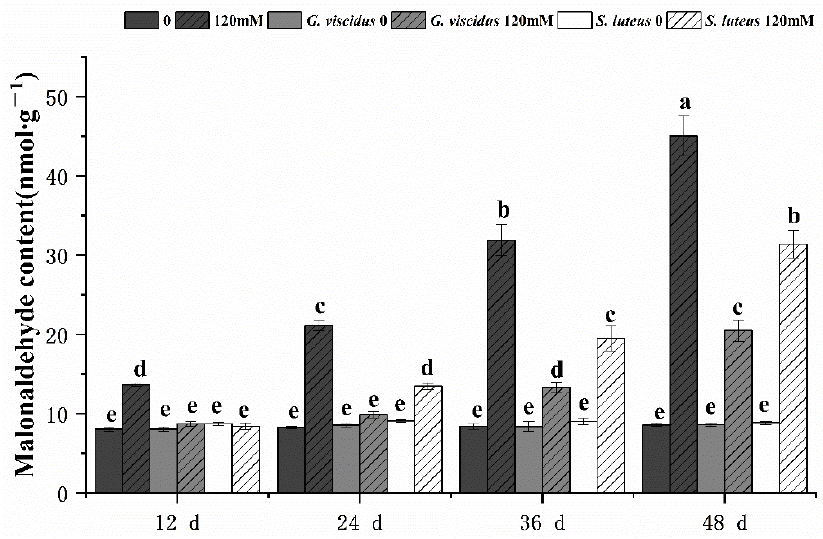
Figure 9. Changes in the malonaldehyde content in ectomycorrhizal seedlings of Q. mongolica under NaCl stress. Bars represent means of five replicates ( ± SD). For each parameter, bars with different letters indicate significant differences among treatments, p ≤ 0.05, following one-way ANOVA.